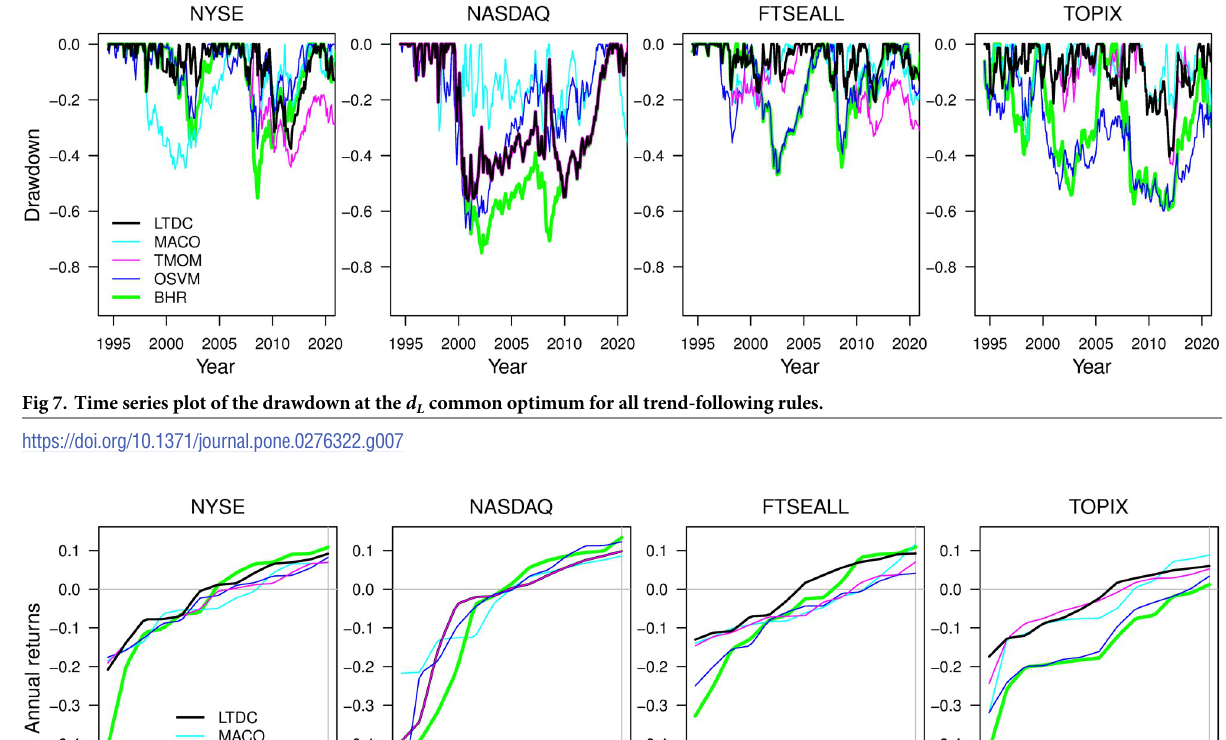
common optimum for all trend-following rules. L